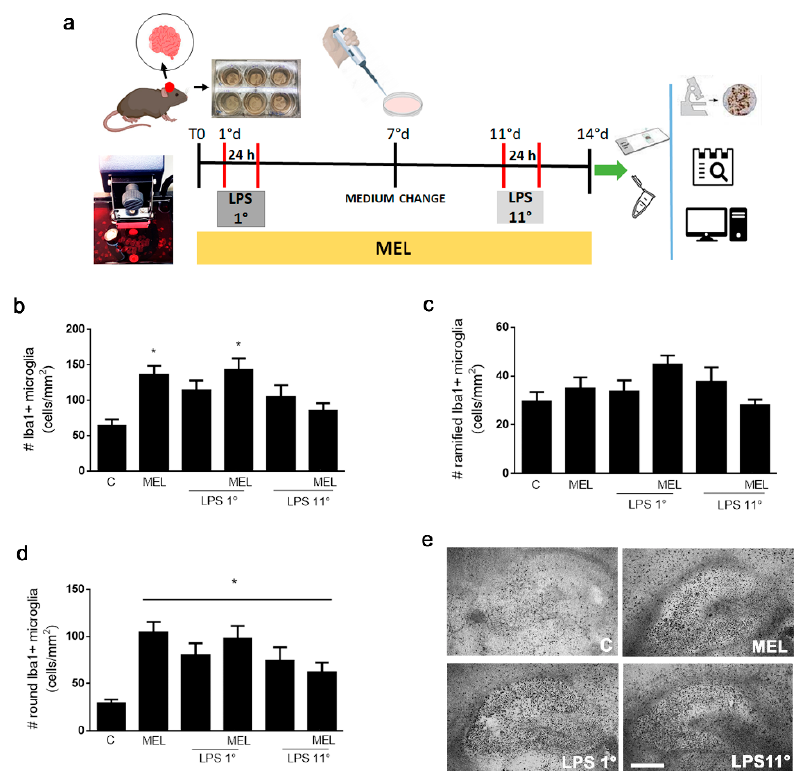
Figure 3. Morphological changes induced by MEL and LPS. As outlined in panel ( a ), brains were isolated and sectioned with a vibratome; the slices were transferred to membrane inserts into a cul- ture plate and exposed to LPS (0.1 μ g/mL) for 24 h, either on the first day after culture (LPS 1°) or on the eleventh day (LPS 11°) and further cultured for a total of 14 days in vitro. Melatonin (MEL; 1 μ M) was added to OCs for 14 days, with or without LPS. Untreated condition is indicated as C. Microglial cells were immunolabeled with Iba1, counted and graphed as the total ( b ), ramified ( c ) or round ( d ) cell numbers (#). In ( e ), representative images of the distribution of Iba1-positive microglia in the whole hippocampal area. Scale bar = 580 μ m. Data are means ± SEM with n ≥ 3. * p ≤ 0.05 vs. C by one way-ANOVA followed by Fisher LSD test post hoc for significance.